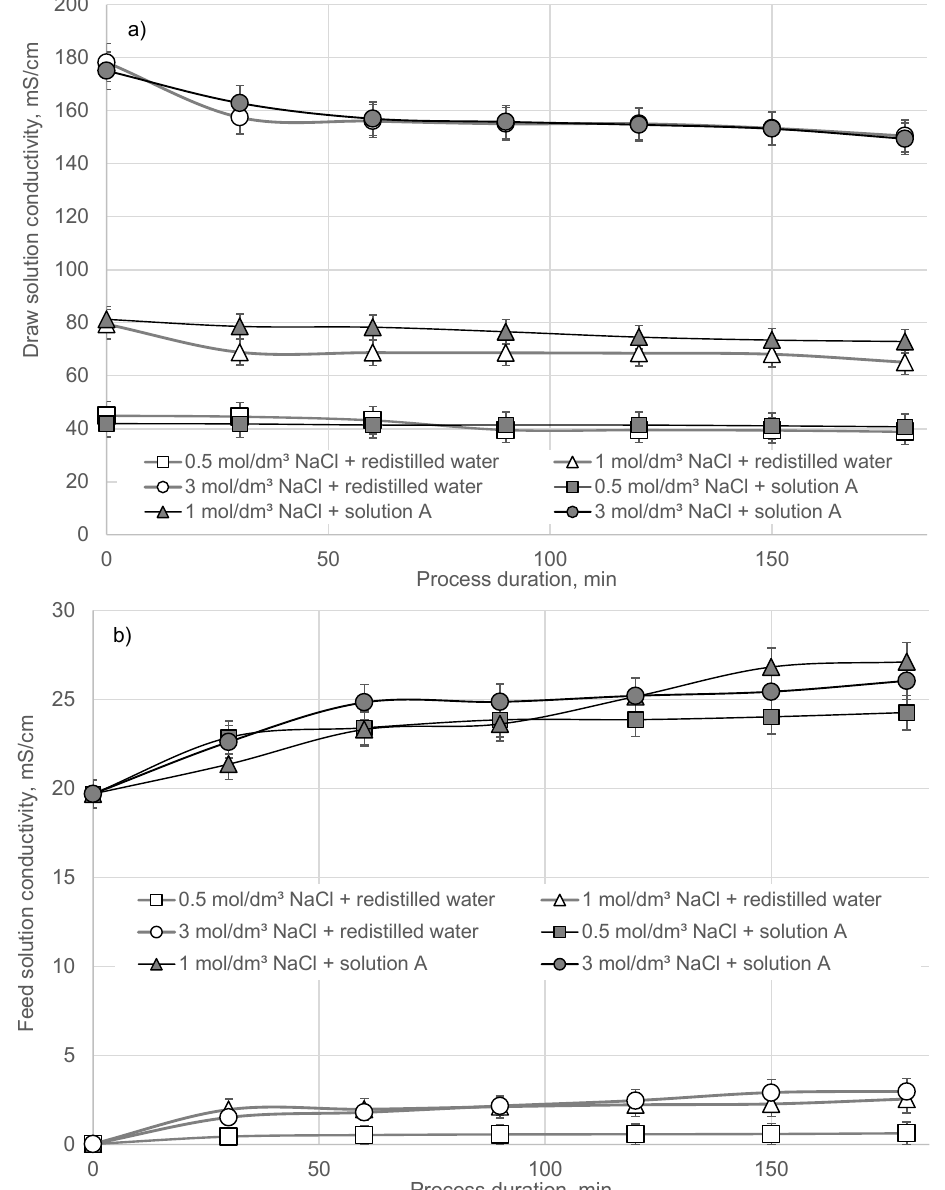
Figure 5. Changes of the conductivity in: ( a ) the draw solution and ( b ) the feed solution with the FO process duration.